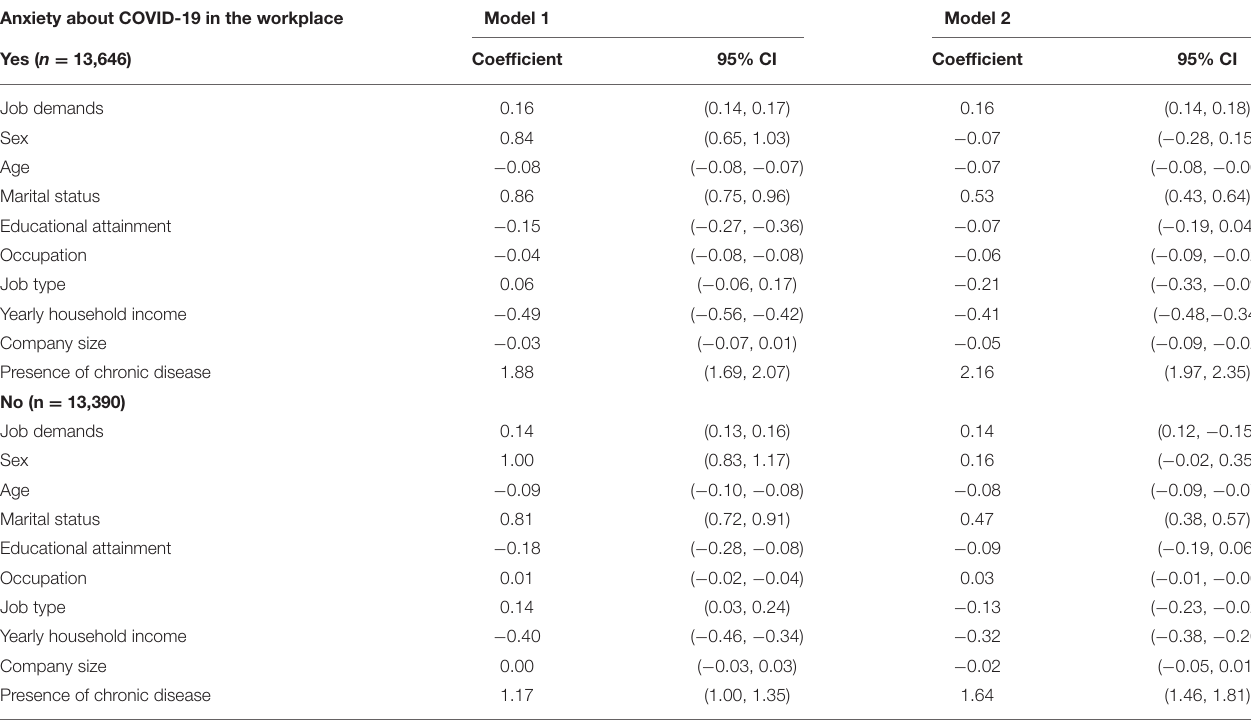
TABLE 2 | Associations between job demands and K6 score by anxiety about workplace COVID-19 infection ( n = 27,036). Anxiety about COVID-19 in the